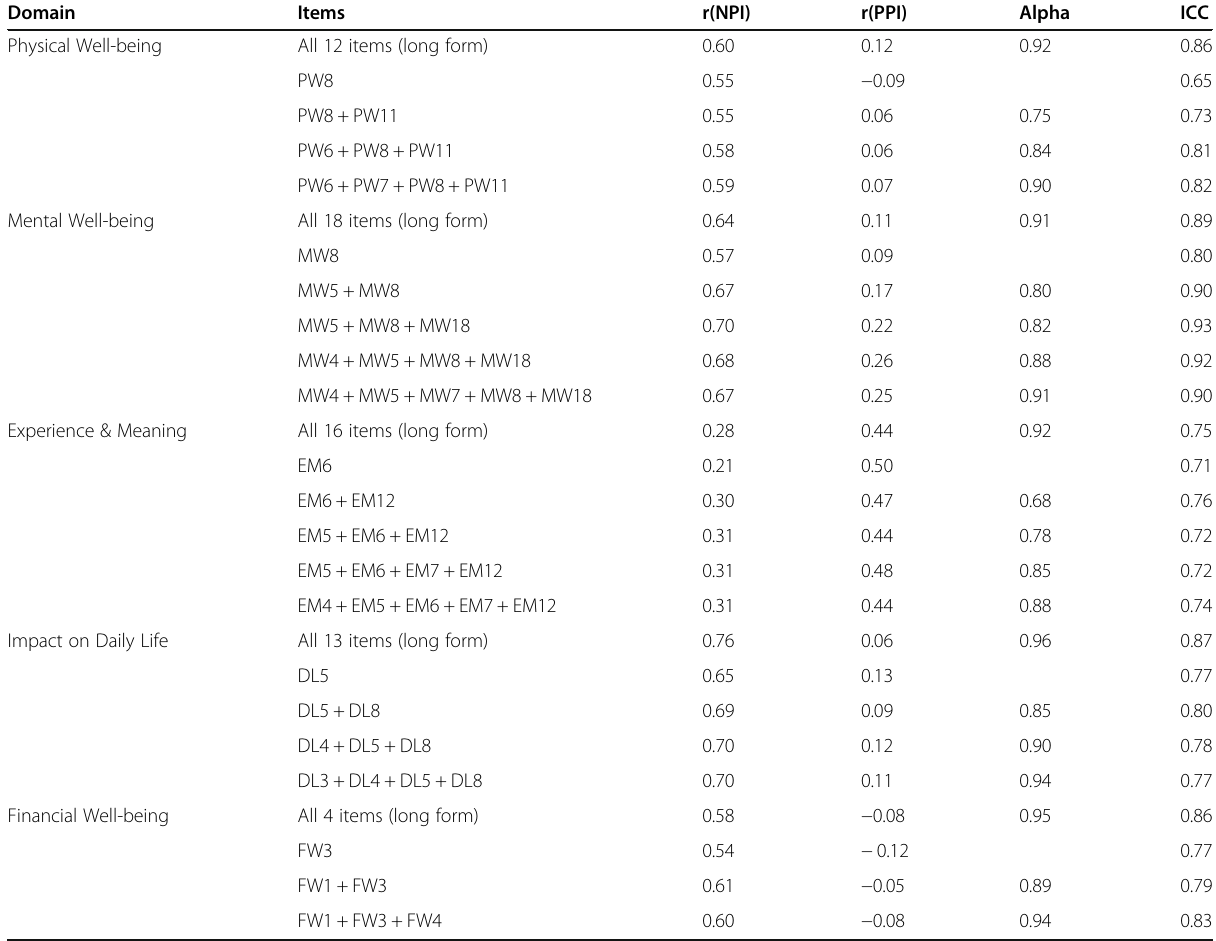
Table 3 Measurement properties of the long form and selected n -item subsets for each domain Domain Items r(NPI) Physical Well-being All 12 items (long form)